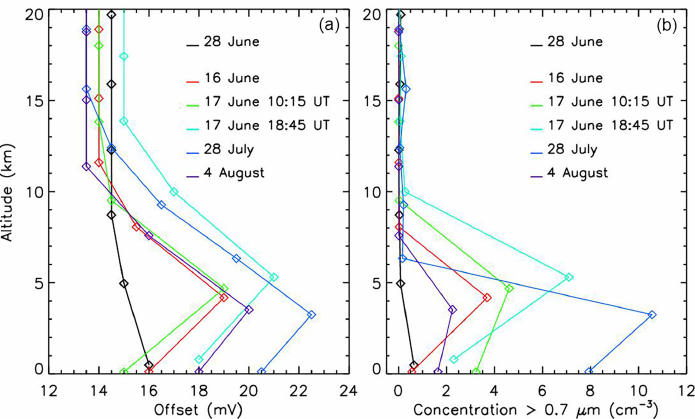
Figure 17. (a) Profiles of the LOAC electronic offset in the case of crossing a strong dust plume (16 June, 17 June mid-day and evening, 28 July, and 4 August) and in the case of a weak dust plume just close to ground on 28 June. (b) Profiles of number concentrations of dust particles larger than 0.7µm for the same